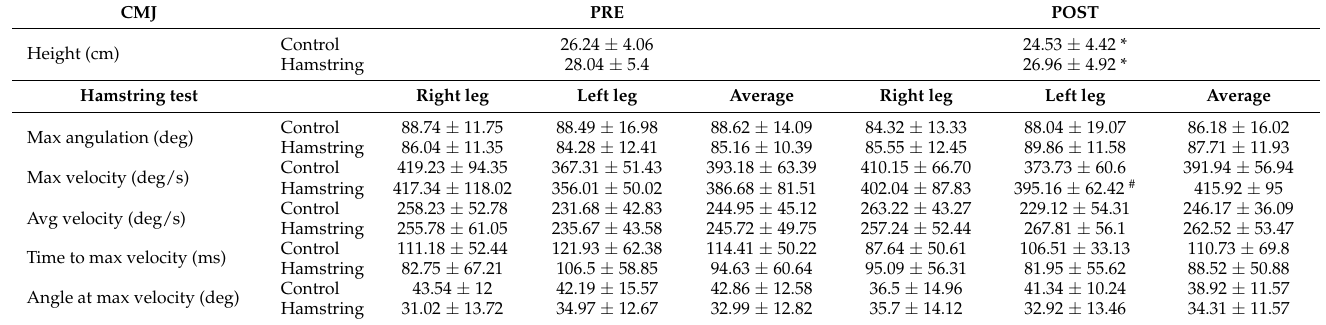
Table 2. Results of the Countermovement Jump and the Hamstring Test before RSA (PRE) and after RSA